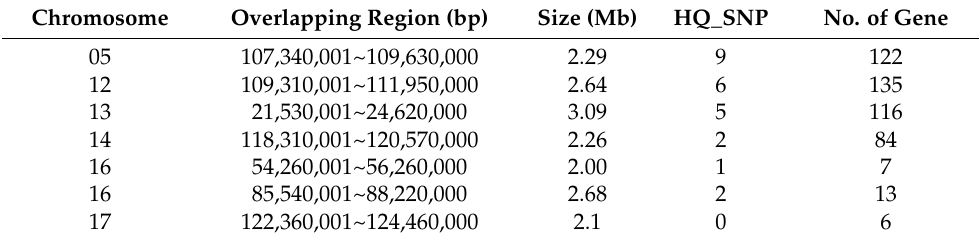
Figure 2. Mapping of genomic regions associated with LTG tolerance based on BSA-Seq fitting and plotting by Ggplot2. ( A ), Manhattan plot analysis on distribution of ∆ SNP-index on chromosomes. ( B ), The Manhattan plot analysis on distribution of the square of the ED on the chromosomes. The abscissa indicates the chromosome number, the blue and red lines represent 95% and 99% confidence intervals, respectively. The candidate association region for LTG tolerance is framed. The data was fitted and plotted by Ggplot2. Table 3. Analysis of candidate regions associated with LTG